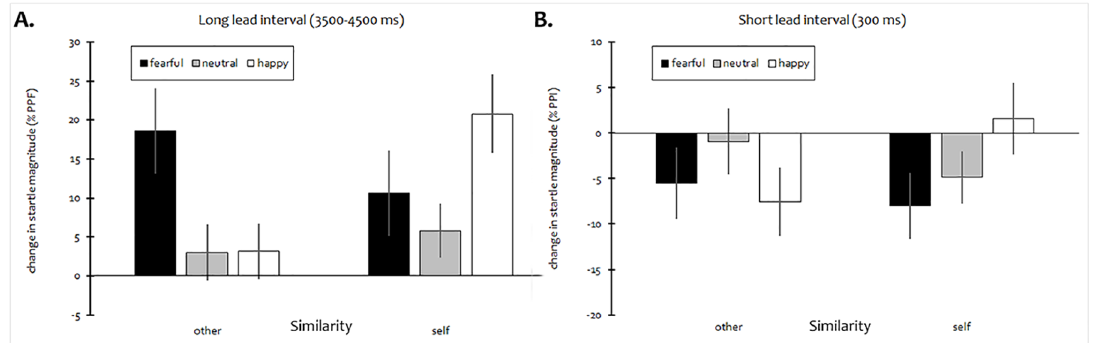
Fig 2. Mean proportional change in startle magnitude during presentation of morphed faces with different emotional expressions as a function of facial resemblance(self vs. other). A. long lead interval (3500–4500 ms, PPF), B. short lead interval (300 ms, PPI). Error bars represent